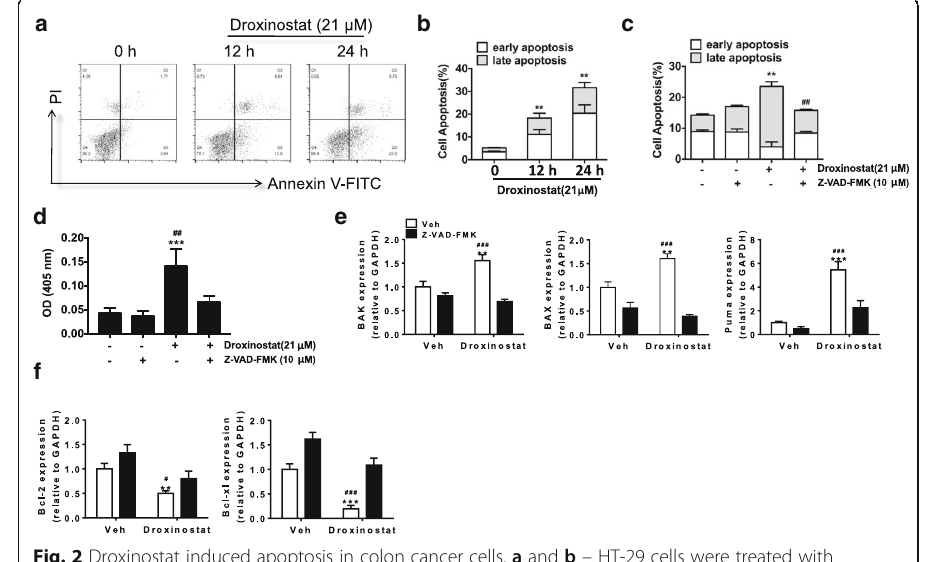
Fig. 2 Droxinostat induced apoptosis in colon cancer cells. a and b – HT-29 cells were treated with droxinostat for 12 and 24 h. Cellular apoptosis was measured with annexin V and PI staining. The percentages of positive cells in the upper right and lower right quadrants represent later and early apoptotic cells, respectively. Data are expressed as the means ± SD of three independent experiments. ** p < 0.01 vs vehicle. c – HT-29 cells were treated with 10 μ M Z-VAD-FMK followed by 21 μ M droxinostat treatment for 24 h. Cellular apoptosis was measured using annexin V and PI staining. Apoptotic data are expressed as the means ± SD of three independent experiments. * p < 0.05 vs. vehicle, ** p < 0.01 vs. vehicle, ## p < 0.01 vs droxinostat. d – HT-29 cells were treated with 10 μ M Z-VAD-FMK followed by 21 μ M droxinostat treatment for 24 h. The activity of caspase-3 was measured at 405 nm and expressed as optical density (OD). e and f – HT-29 cells were incubated with droxinostat for 24 h. Expressions of pro- and anti-apoptotic related genes were measured using RT-PCR. ** p < 0.01, *** p < 0.001 vs Veh; # p < 0.05, ### p < 0.001 vs